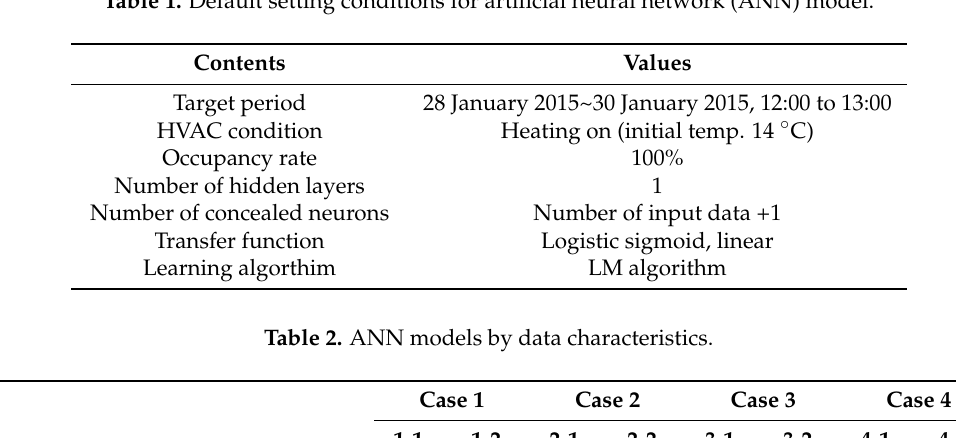
Table 1. Default setting conditions for artificial neural network (ANN) model.